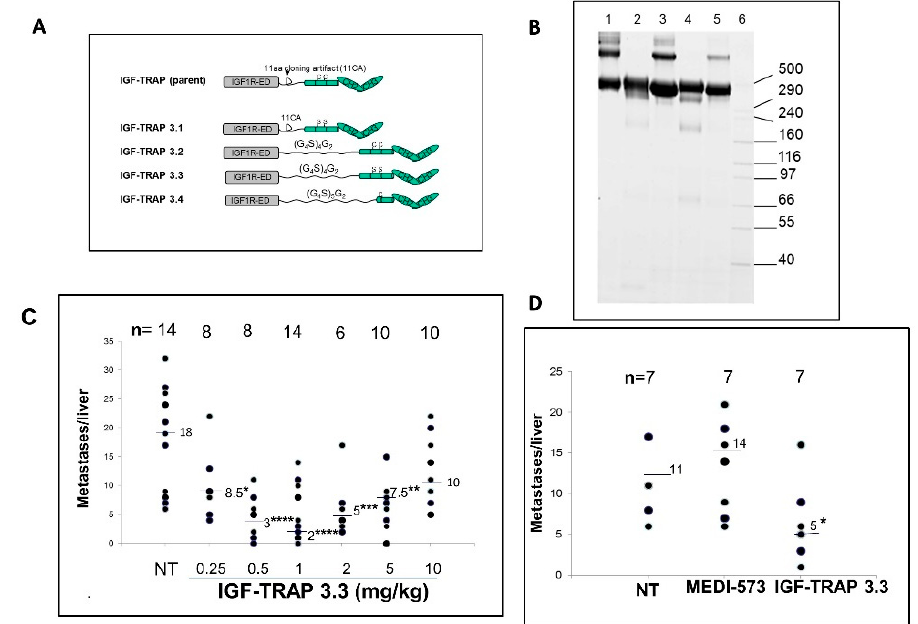
Figure 4. Cysteine-serine substitutions in the Fc domain of the IGF-Trap reduce high-molecular-weight (HMW) oligomers and improve pharmacodynamic properties. Shown in ( A ) is a schematic representation of the modifications engineered in the parent (2 nd generation) IGF-Trap and in ( B )